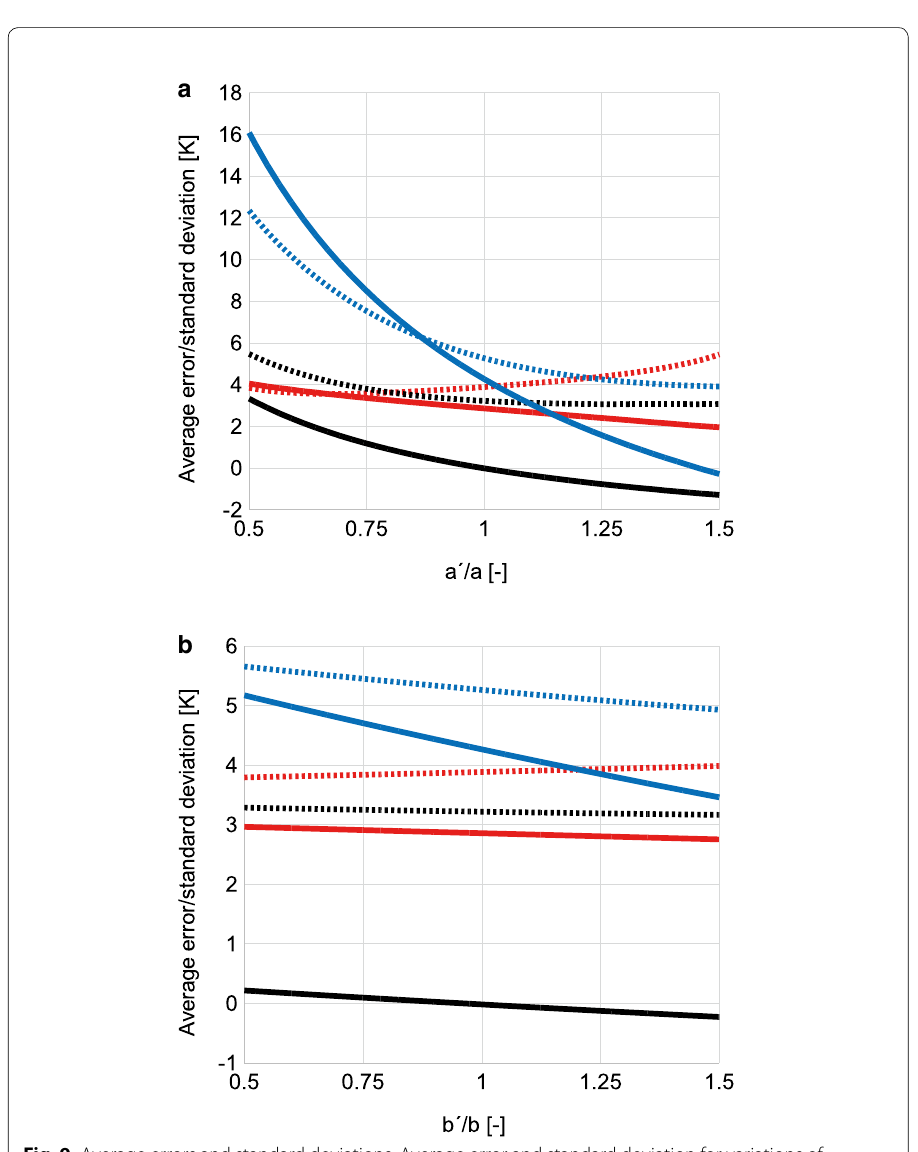
Fig. 9 Average errors and standard deviations. Average error and standard deviation for variations of a parameter a and b parameter b . Given are normalised parameter values with a ′ and b ′ denoting the parameter variations and a and b the original values according to Eq. 1. Blue lines: results for method A; black lines: results for method B; red lines: results for method C. Solid lines: average errors; dashed lines: standard deviations